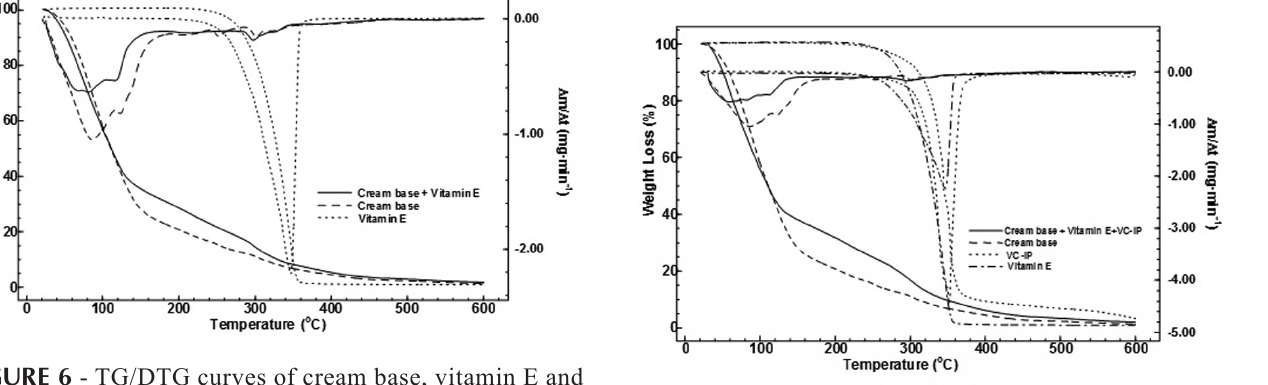
FIGURE 8 - TG/DTG curves of cream base, VC-IP, vitamin E and cream base with VC-IP and vitamin E samples obtained in a mixture of air (20 mL min -1 ) and N2 (50 mL min -1 ) under a dynamic atmosphere and at a heating rate of 10 ºC min -1